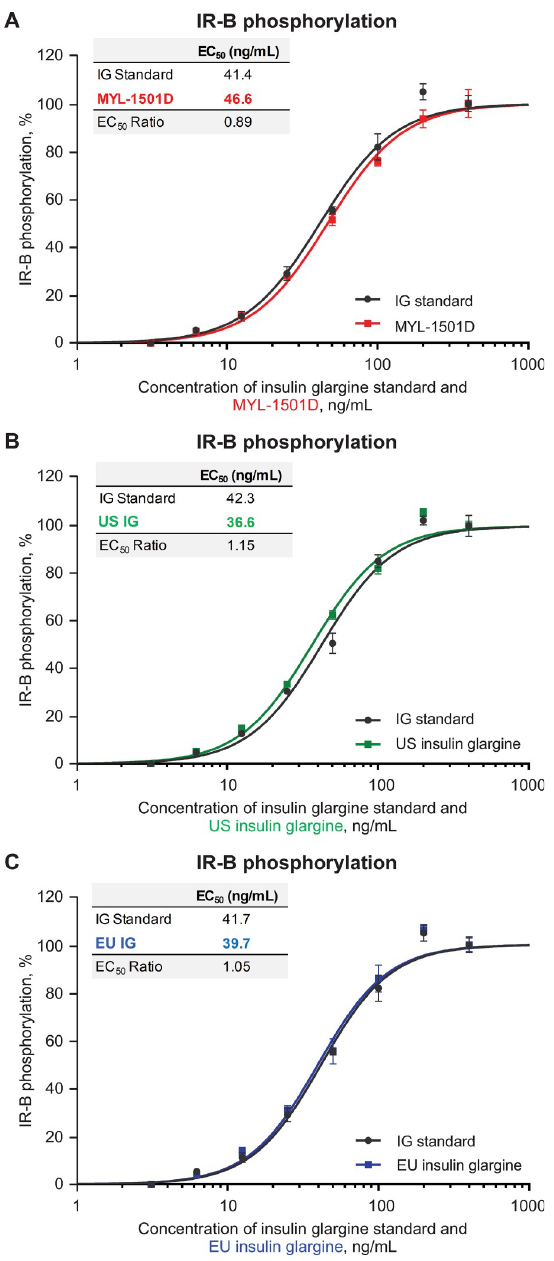
Fig 10. Representative dose-response curves of insulin receptor-B (long-form) phosphorylation assay. Recombinant CHO-K1 Cells Expressing Insulin Receptor-B were used in the assay. (A) MYL-1501D, (B) US-Licensed Insulin Glargine, and (C) EU-Licensed Insulin Glargine. All samples were analyzed against a common insulin glargine reference standard (IG standard) to normalize against day-to-day variability. Each lot was analyzed using 3 independent dilution preparations on an assay plate. Mean ± SEM for the % phosphorylation response is plotted (y- axis) against the concentration (x-axis). Four parameter logistic curve fit was applied to evaluate EC 50 . Each sample was analyzed on 3 independent assay plates, and average is reported. CHO, Chinese hamster ovary; EC 50 , half maximal effective concentration.